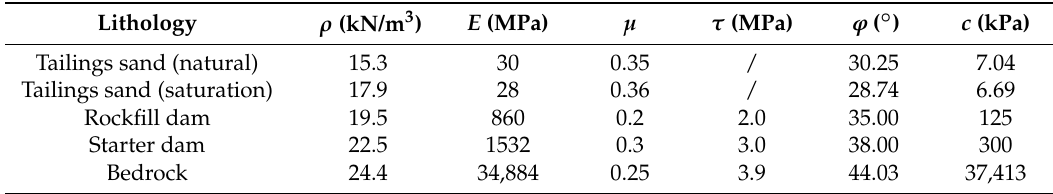
Table 2. Calculation parameters for the numerical model.